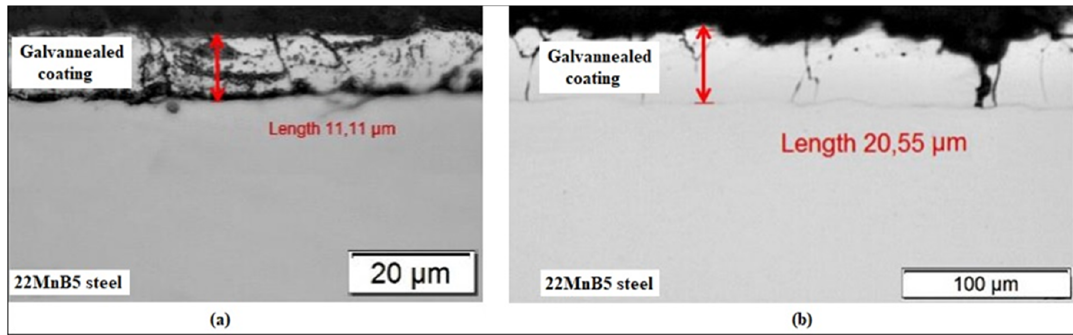
Figure 2. ( a ) Metallic coating formed on 22MnB5 steel before the hot stamping process; ( b ) Metallic coating formed on 22MnB5 after the hot stamping process.